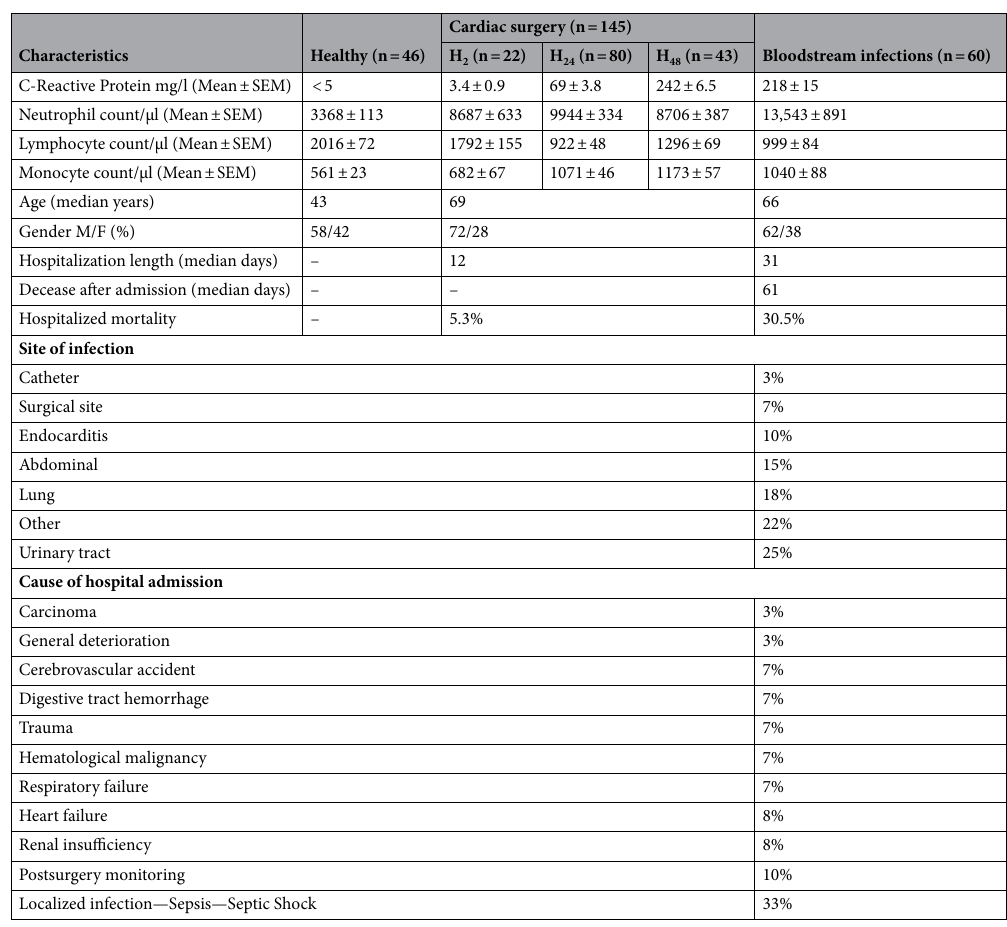
Table 1. Demographic and laboratory characteristics of